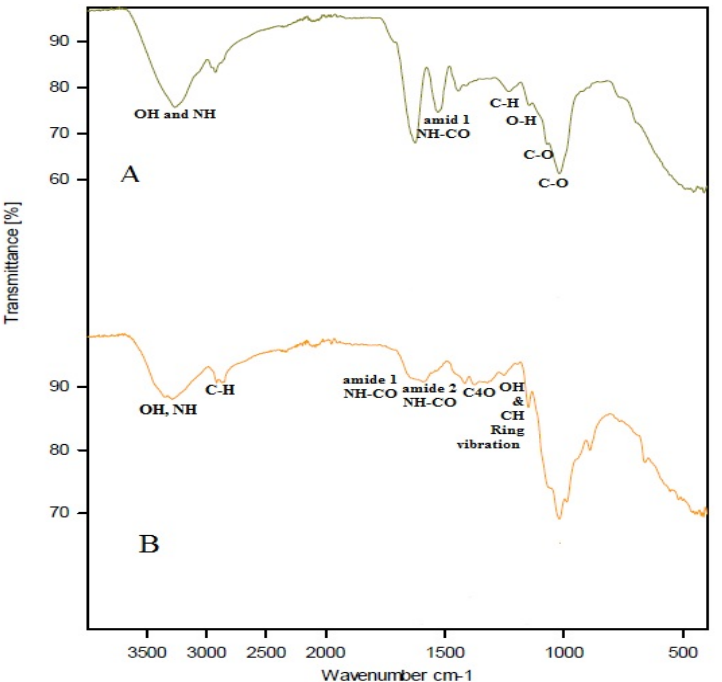
Figure 2. FTIR of A —Se/chitosan-folic acid. The IR for Se/chitosan-folic acid showed peaks attributed to NH 2 and OH stretching between 3265 cm − 1 and 2928 cm − 1 (broad band). In addition, a shift was observed at 1529 cm − 1 for amide I peak 1 in Se/chitosan-folic acid and stretching vibrations of C–O at 1019 cm − 1 and 892 cm − 1 (sharp band), corresponding to changes occurring after complexation with folic acid. Due to the O–H ring, there was a peak at 1400 cm − 1 (weak band), which disappeared in the Se/chitosan-folic acid spectrum, and a new other peak appeared at 1398 cm − 1 (weak band). B —chitosan. The IR for chitosan showed a peak at 3290 cm − 1 (broad band) referring to the vibrational stretching motions of the OH and NH 2 groups. The peaks at 2920 cm − 1 and 2885 cm − 1 (very weak band) were due to the vibration of C–H, and that at 1635 cm − 1 was due to the amide I group NH–CO (broad shoulder band). The NH–CO amide group II appeared at 1595 cm − 1 (broad shoulder band). The peaks at 1420 cm − 1 and 1335 cm − 1 refer to the OH and C–H vibrations, respectively. Therefore, there is a chelation occurring between selenium, folic